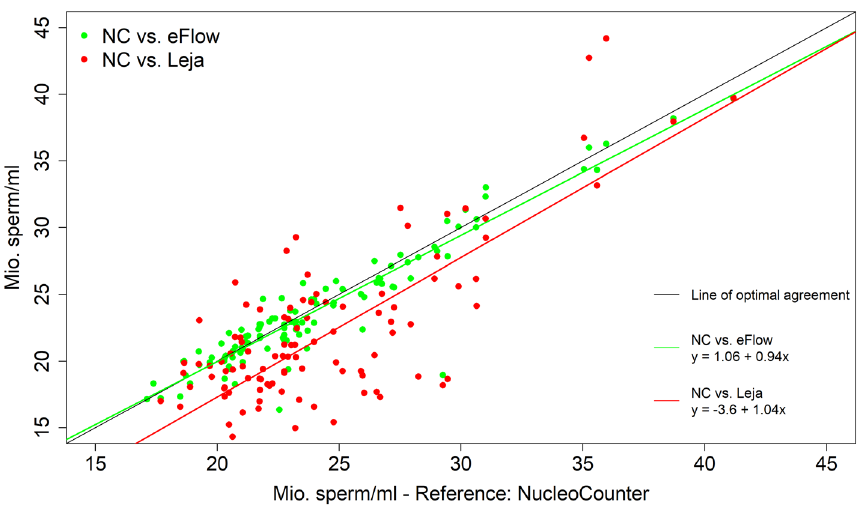
Figure 5. Comparison of boar sperm concentrations (diluted semen) measurements methods. ANDROVISION eFlow and disposable counting chambers (Leja) were tested against the NUCLEOCOUNTER (NC), respectively. The linear regressions are defined as y = 1.06 + 0.94 × for ANDROVISION eFlow and y = − 3.6 + 1.04 × for ANDROVISION with Leja